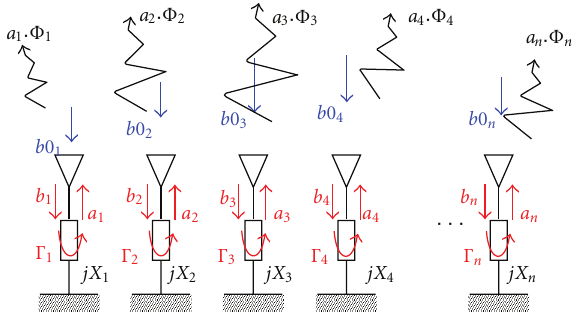
Figure 35: The illumination of the reactive panel by the external feed injects b 0 i in each